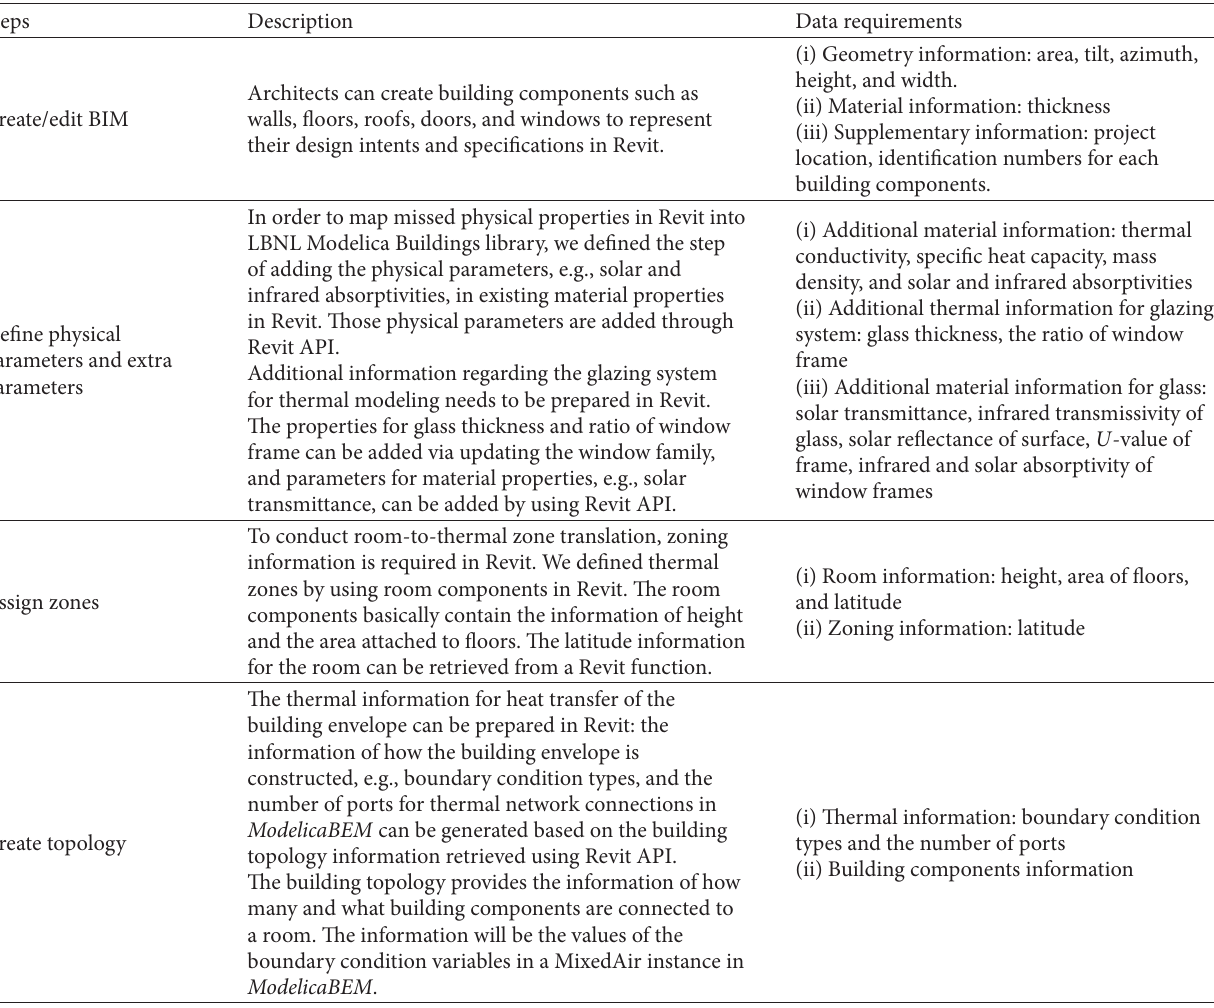
Table 2: Defined steps and required